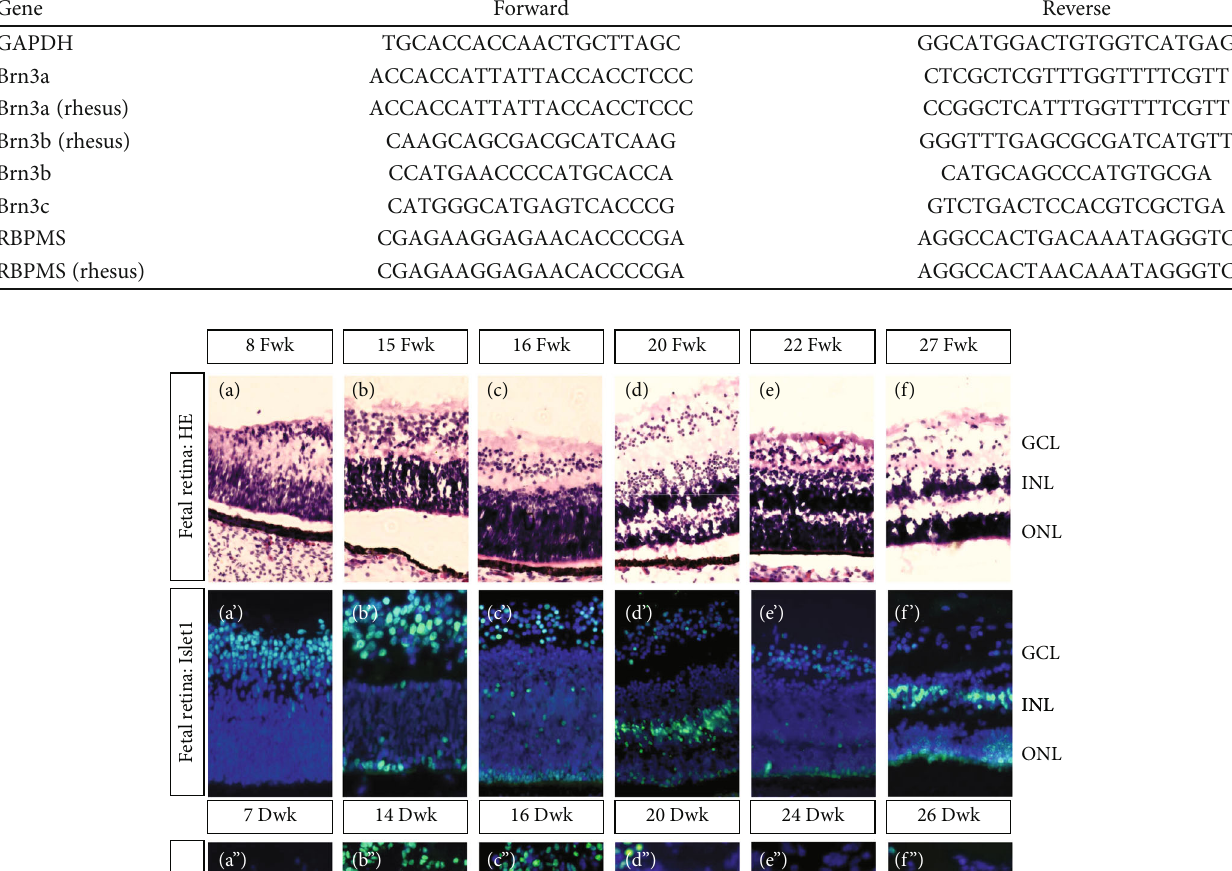
Table 1: Primer used in real-time PCR.